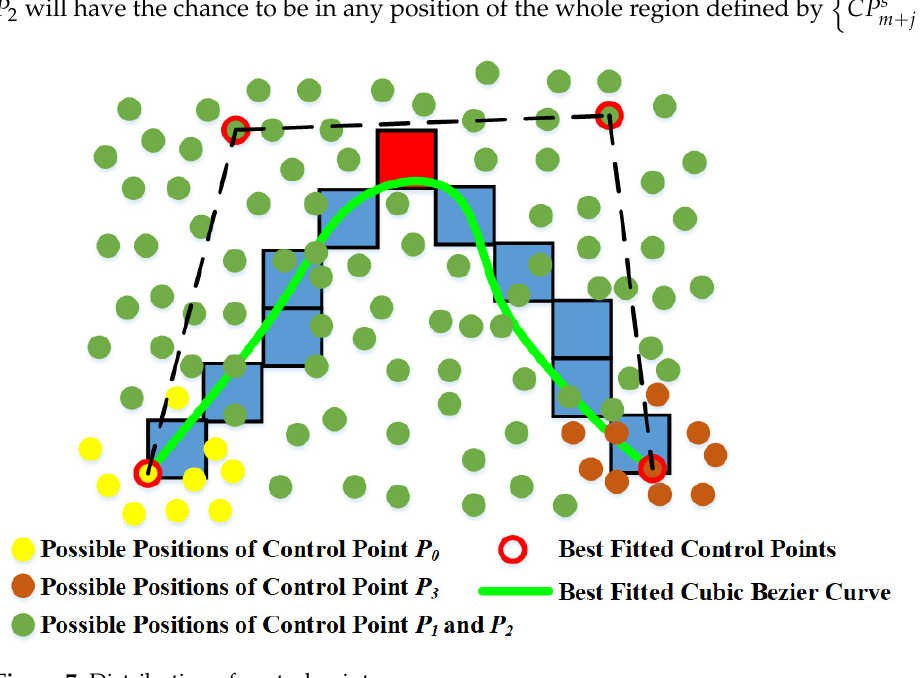
Figure 7. Distribution of control points.